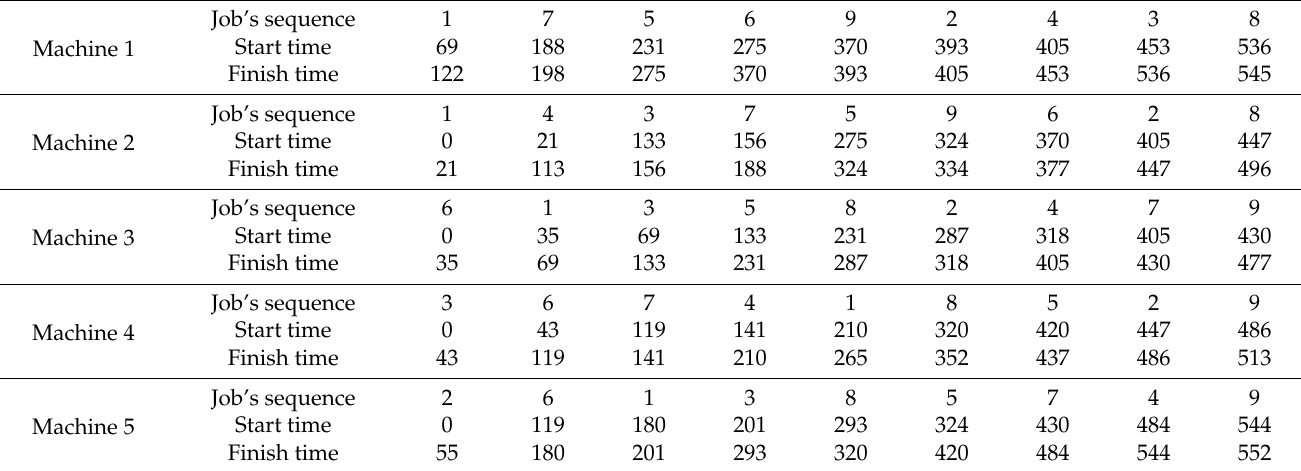
Table 5. The best solution of the 6 × 5 DJSSP with IHKA